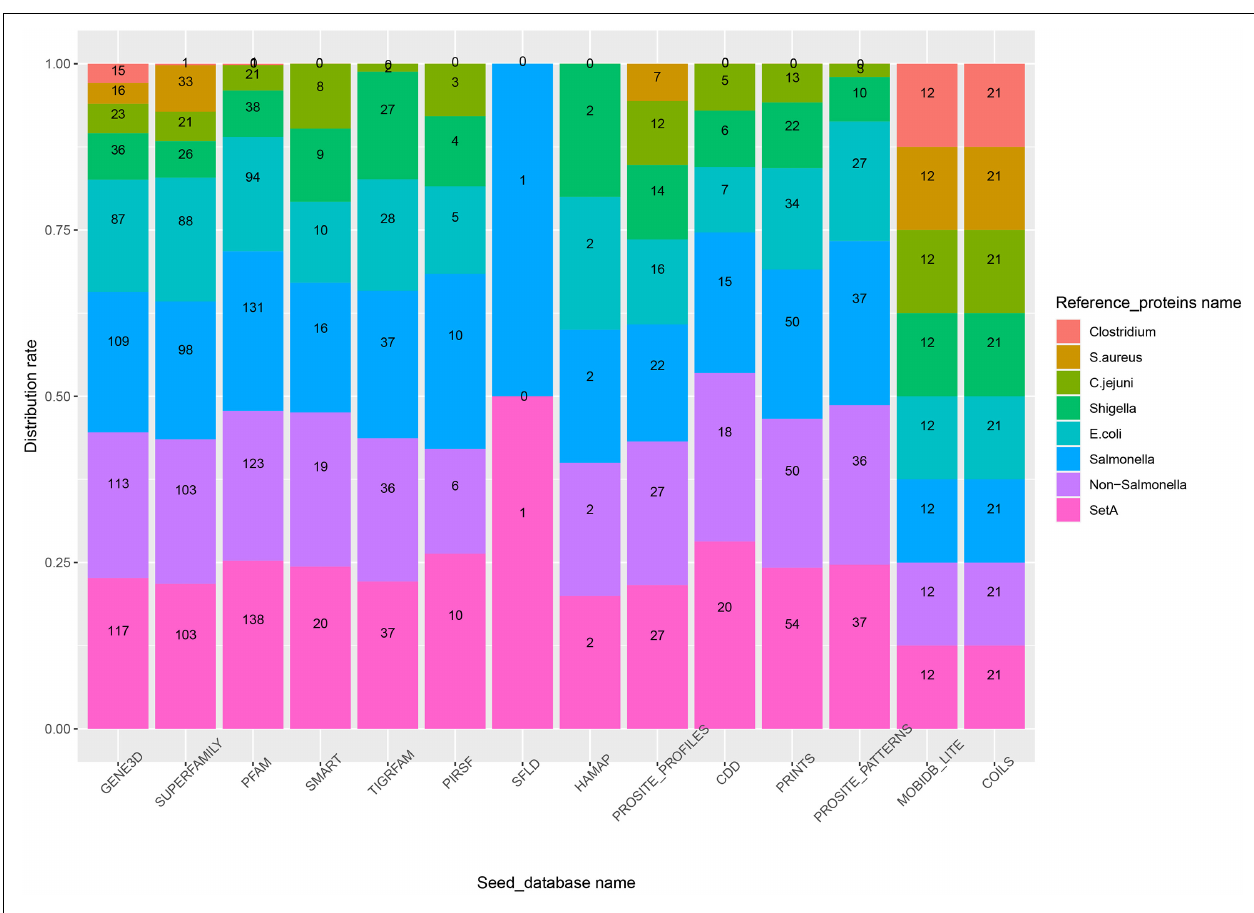
FIGURE 4 | The number of experimentally verified virulence associated proteins in S. Typhimurium (numbers inside bars is verified numbers) among the predicted proteins depending on the source of the reference proteins (color of bars) and the Seed_database used. The scale on the Y-axis shows the accumulated percentage of verified numbers by that database when the results from different Reference_protein group were stacked on top of each